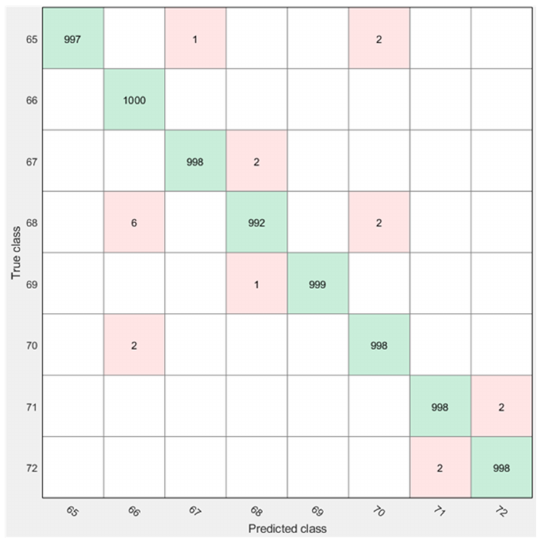
Figure 7. Confusion Matrix of Cubic SVM on non-optimized